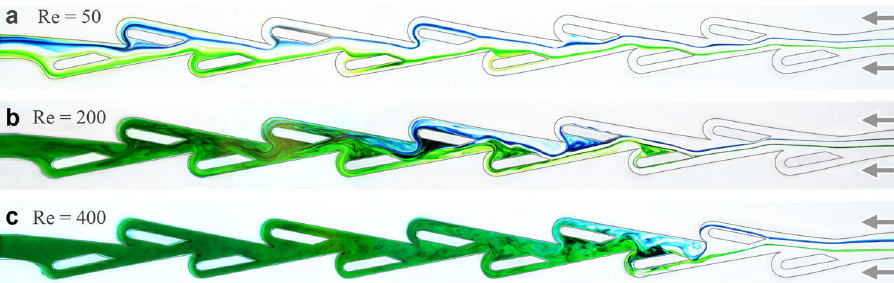
Fig. 4 Transition in reverse fl ow state with increasing Reynolds number. a Streakline visualization at Re ¼ 50. Blue and green dyed fi laments disperse but do not intermix, and the fl ow is steady throughout the conduit. a At a transitional value of Re ¼ 200, the fi laments are laminar and steady for the fi rst few units, unsteady and intermix in the middle, and are nearly completely mixed by the end of the conduit. c At Re ¼ 400, unsteady and well-mixed fl ows appear throughout most of